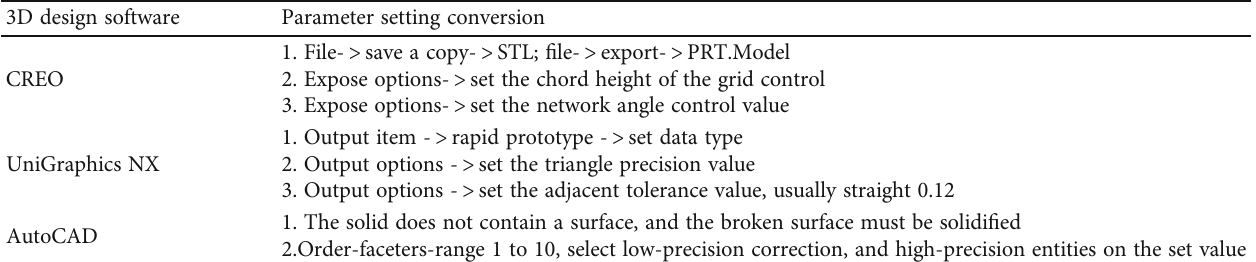
Table 1: File format conversion rules and related content technical parameters of commonly used architectural design and engineering 3D model